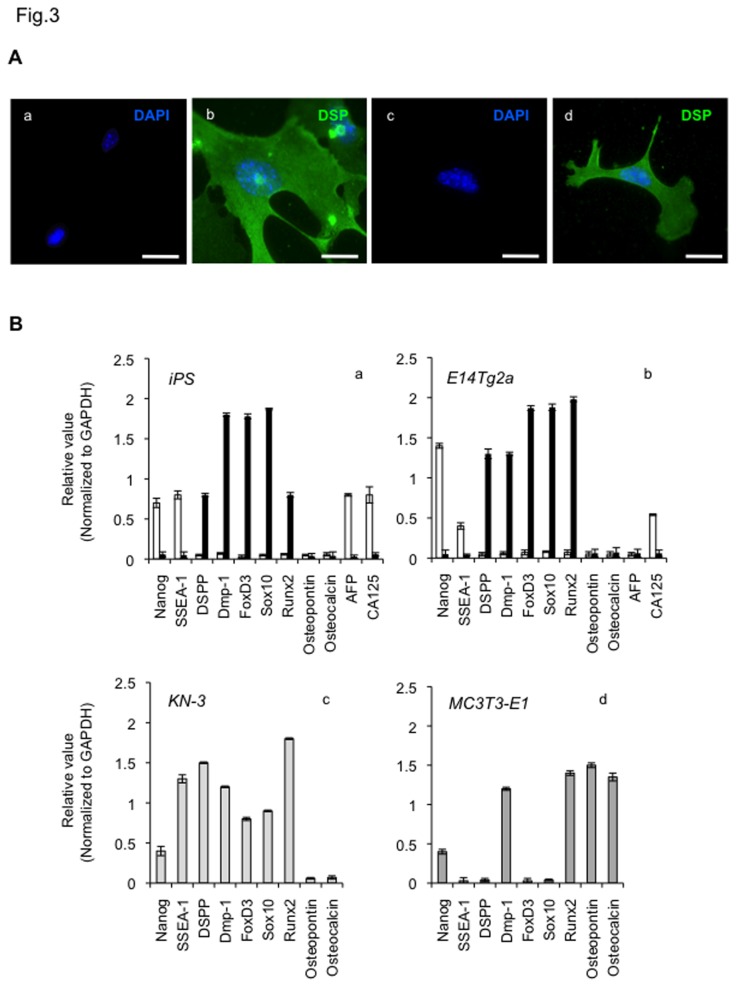
Odontoblastic differentiation of iPS cells on CS/BMP-4.(A) Immunofluorescence staining for the odontoblastic cell marker, dentin sialoprotein (DSP). Images show iPS cells (a, b) and E14Tg2a cells (c, d) that are undifferentiated (a, c) or differentiated using CS/BMP-4 (b, d). Scale bars = 25 μm. (B) Odontoblastic-related mRNA expression in these differentiated cells. Cells were cultured for 7 days with 10% CS and BMP-4 and the expression of various markers (as shown) assessed by RT-PCR. Rat KN-3 odontoblast-like cells (c) were used as a positive control. Mouse MC3T3-E1 cells (d) were used as an osteoblastic control. Band densities for each cell type cultured in the absence (control: white bars) or presence (black bars) of CS/BMP-4 for 7 days were evaluated using a Multi Gauge-Ver3.X (Fujifilm, Tokyo, Japan). Data are normalized against the housekeeping gene, GAPDH, and are presented as the mean ± SD of at least three independent experiments.